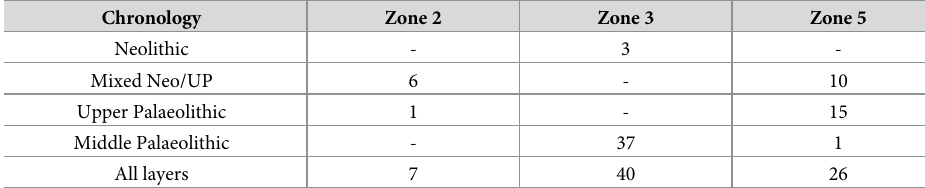
Table 4. Potential ochre finds from excavation zone 2,3,5.